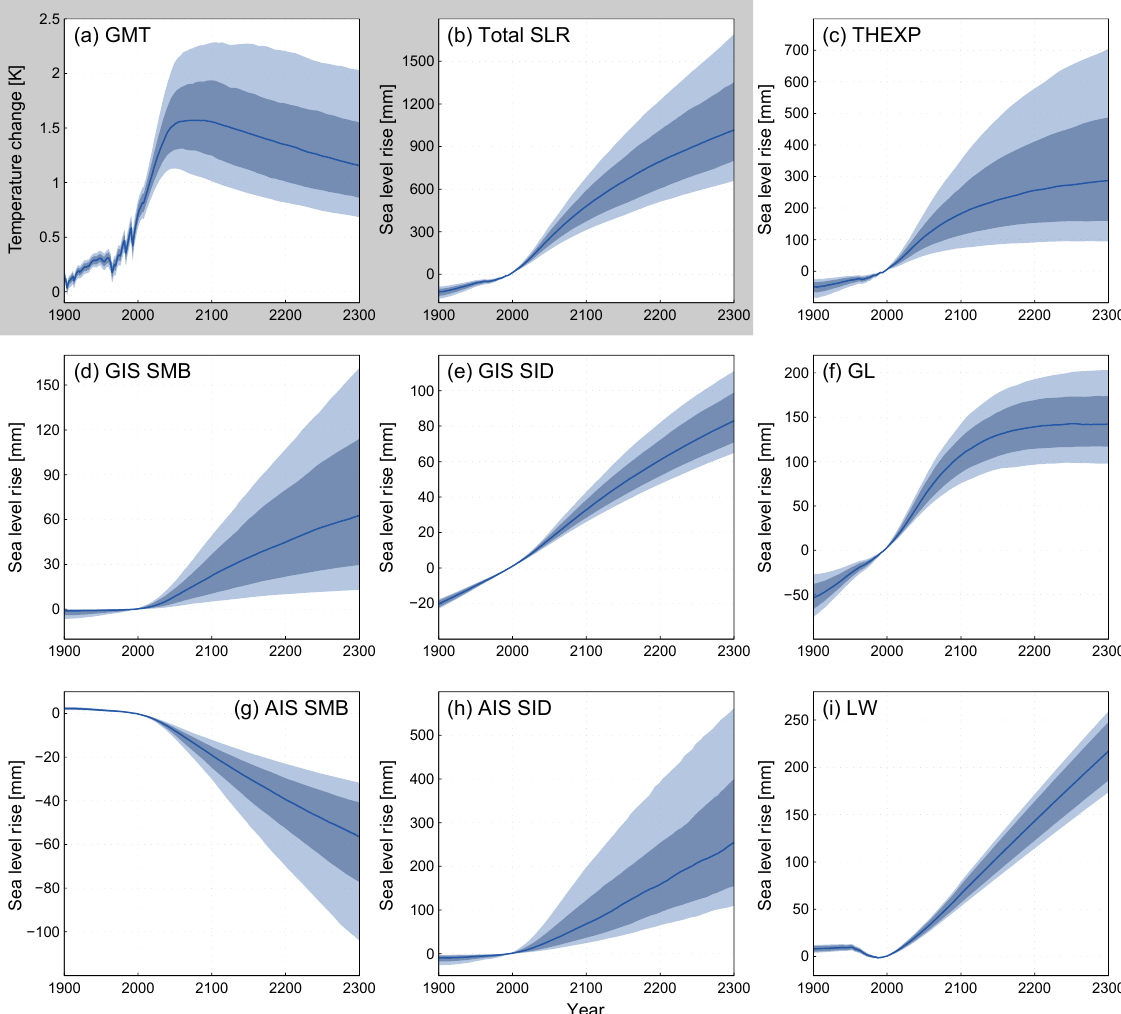
Figure A4. The 1900–2300 SLR projections resolved by the individual MAGICC sea level components for RCP2.6 in millimeters. We show median estimates, 66% ranges in darker shading, and 90% ranges in lighter shading for MAGICC GMT output relative to pre-industrial in panel (a) , total SLR in panel (b) , thermal expansion (THEXP) in panel (c) , Greenland ice-sheet (GIS) SMB and SID in panels (d) and (e) , global glacier (GL) in panel (f) , Antarctic ice sheet (AIS) SMB and SID in panels (g) and (h) , and land water LW in panel (i) . All sea level contributions are provided relative to